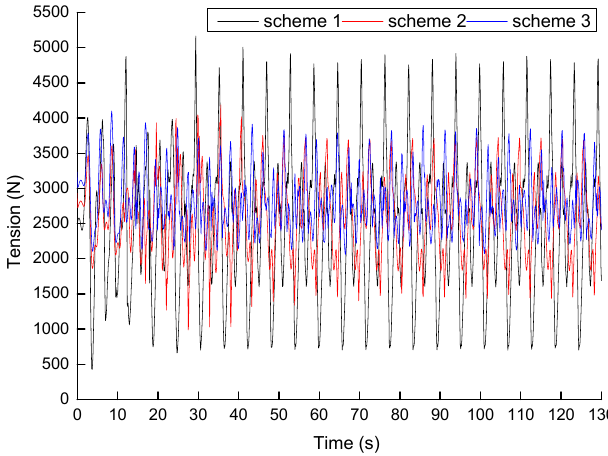
Figure 9. The stress of anchor chain 4 in schemes 1, 2, and 3. The data obtained by simulating regular wave working conditions demonstrate that the symmetric anchor chains have similar stresses and that mooring scheme 2 is the optimal choice considering the stresses of the anchor